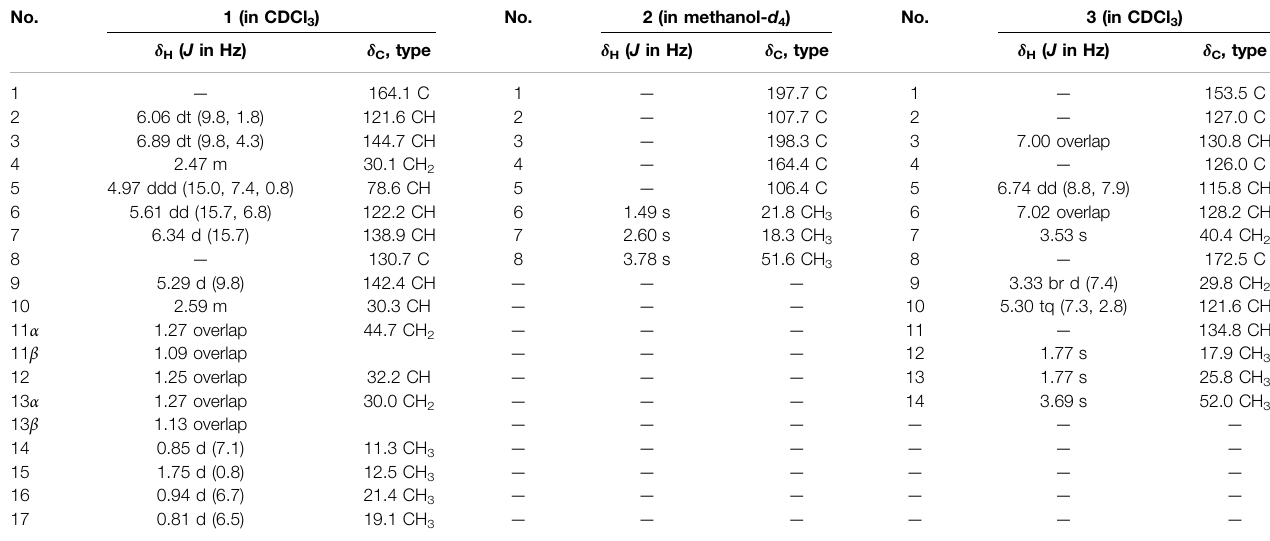
TABLE 1 | 1 H (400 MHz) and 13 C NMR (100 MHz) data for compounds 1 – 3 ( δ in ppm, J in Hz).